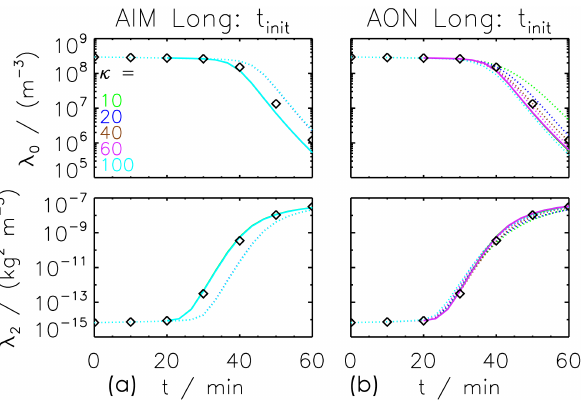
Figure 21. Moments λ 0 and λ 2 as a function of time obtained for the Long kernel by AIM (left) and AON (right). The black symbols depict the moments of the reference solution. The simulations are initialised with Wang’s solution after 20min (solid lines) using the singleSIP-init with various κ values (see legend). The default AON and AIM simulations initialised at t 0, which have been shown = before in Figs. 12 and 18, are depicted by dotted